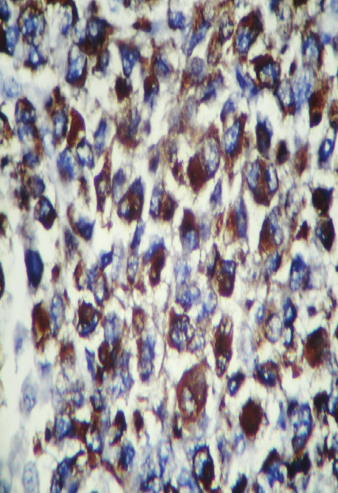
Figure 5: Embryonal rhabdomyosarcoma: desmin immunoreactiv- ity in large eosinophilic cells (IHC × 40).